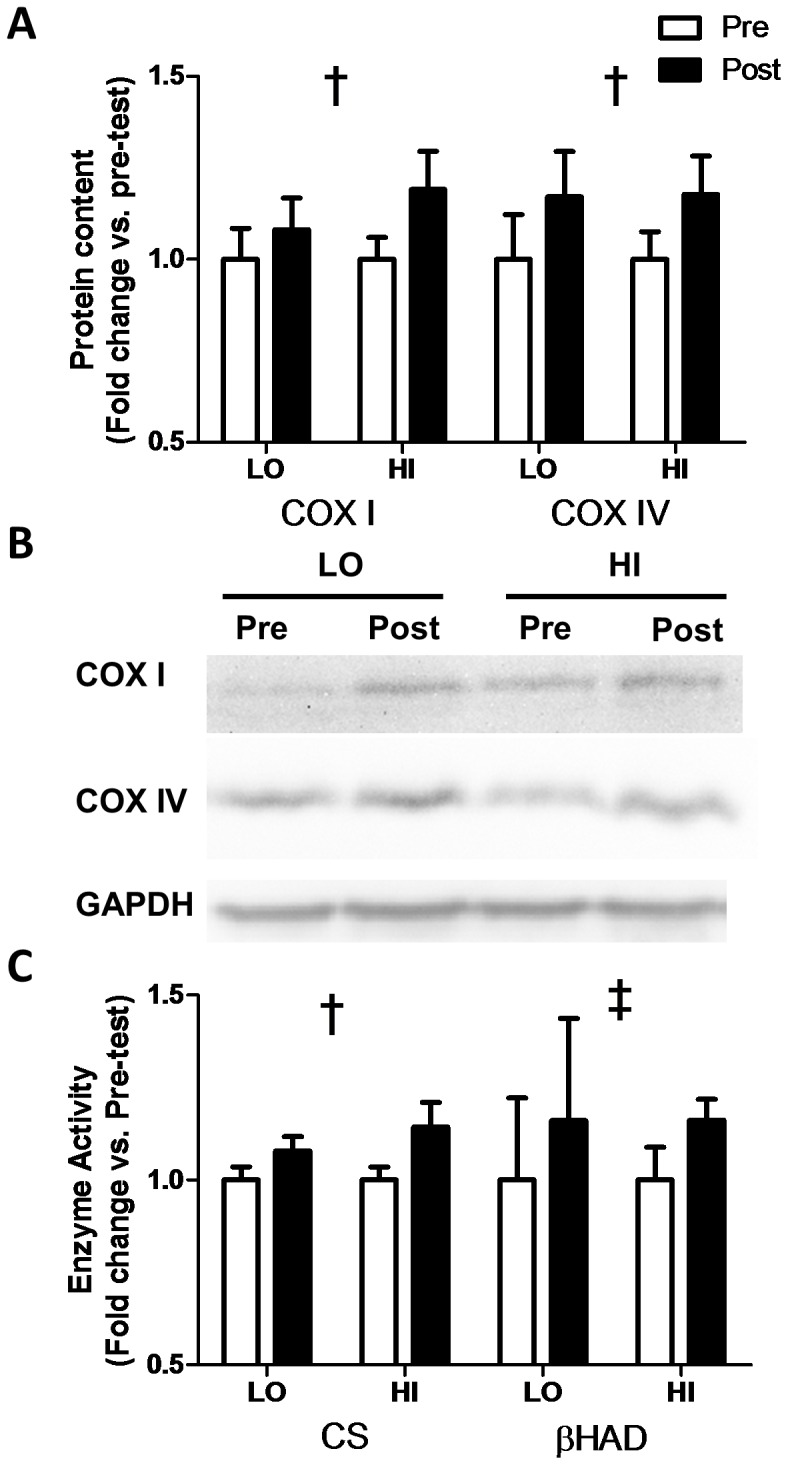
Effect of HI and LO on markers of skeletal muscle oxidative capacity.Changes in protein content of COX I and COX IV (A) and the maximal enzyme activities of citrate synthase (CS) and β-hydroxyacyl-CoA dehydrogenase (βHAD) (C). Representative western blots, including loading controls, are also shown (B). † Significant (p<0.05) effect of training. ‡ Non-significant (p = 0.07) effect of training.